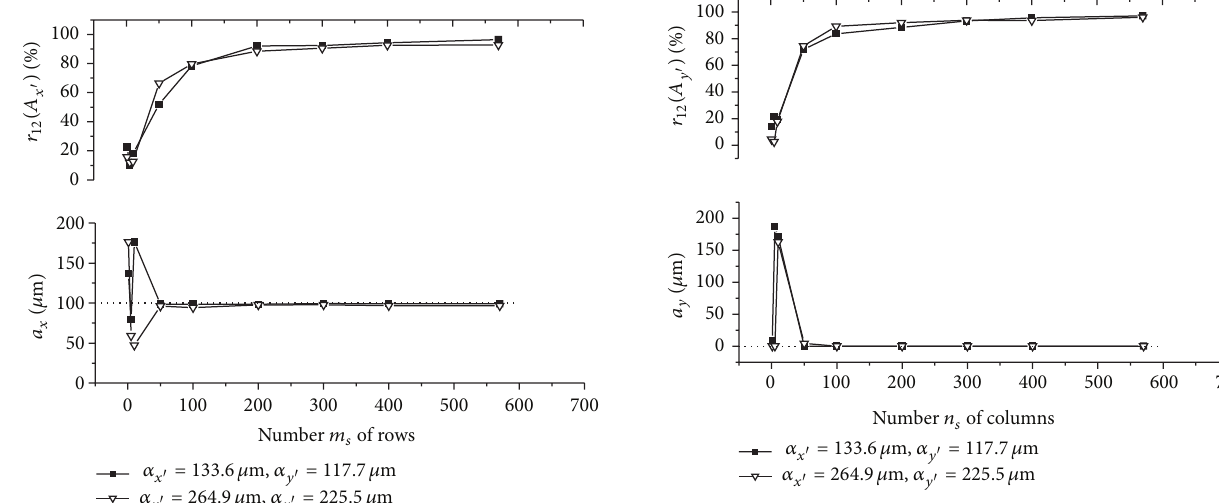
Figure 8: Resultant values of the evaluated object’s translation component 𝑎 𝑥 aswellasthemaximum 𝑟 12 (𝐴 𝑥 󸀠 ) ofthe1Dnormalized cross-correlation function 𝑟 12 of the intensity signals 𝐼 1 and 𝐼 2 as a function of number 𝑚 𝑠 of rows of the area used for the 2D intensity signal processing. The object is translated by 𝑎 𝑥 = 𝑎 𝑦 = 100 𝜇 m.